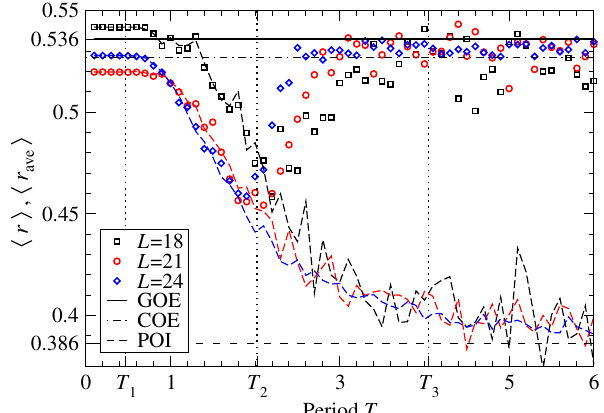
FIG. 2. Average value of r vs T . The values of h r i (symbols) and h r (dashed lines) are compared to the COE, GOE, and ave i POI predictions. The COE and GOE predictions are expected to coincide in the thermodynamic limit (see Appendix B). Vertical dotted lines depict the periods T 1 ¼ 2 π ℏ =W , T 2 ¼ π ℏ = σ , and T 2 π ℏ = σ (see text). 3 ¼